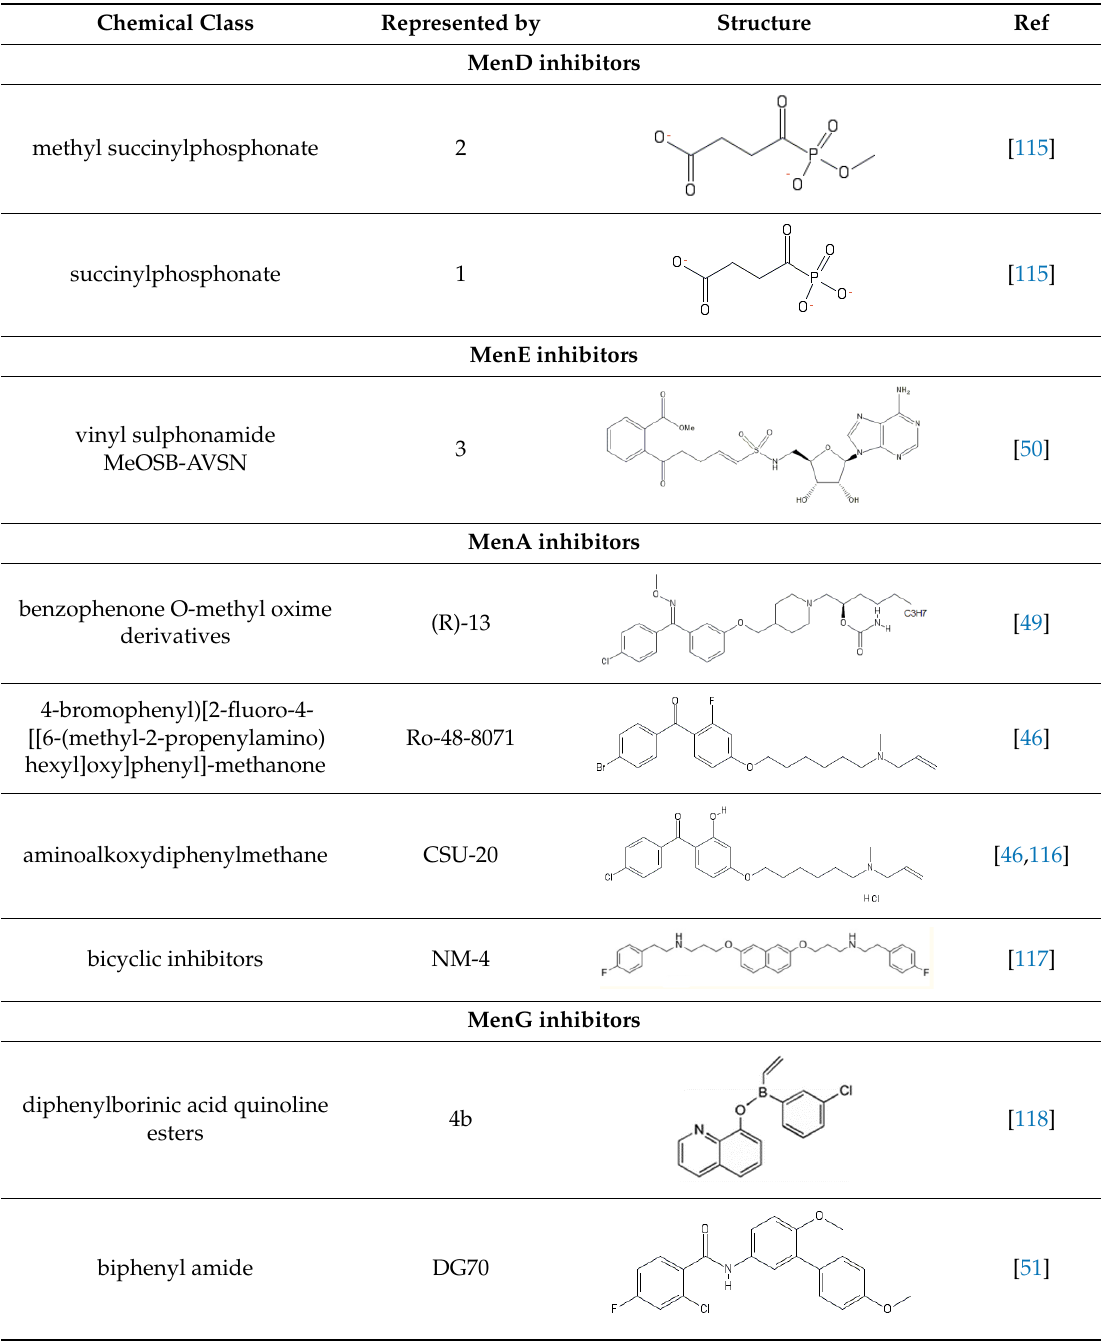
Table 2. Menaquinone (MK) biosynthesis inhibitors discussed in this review.